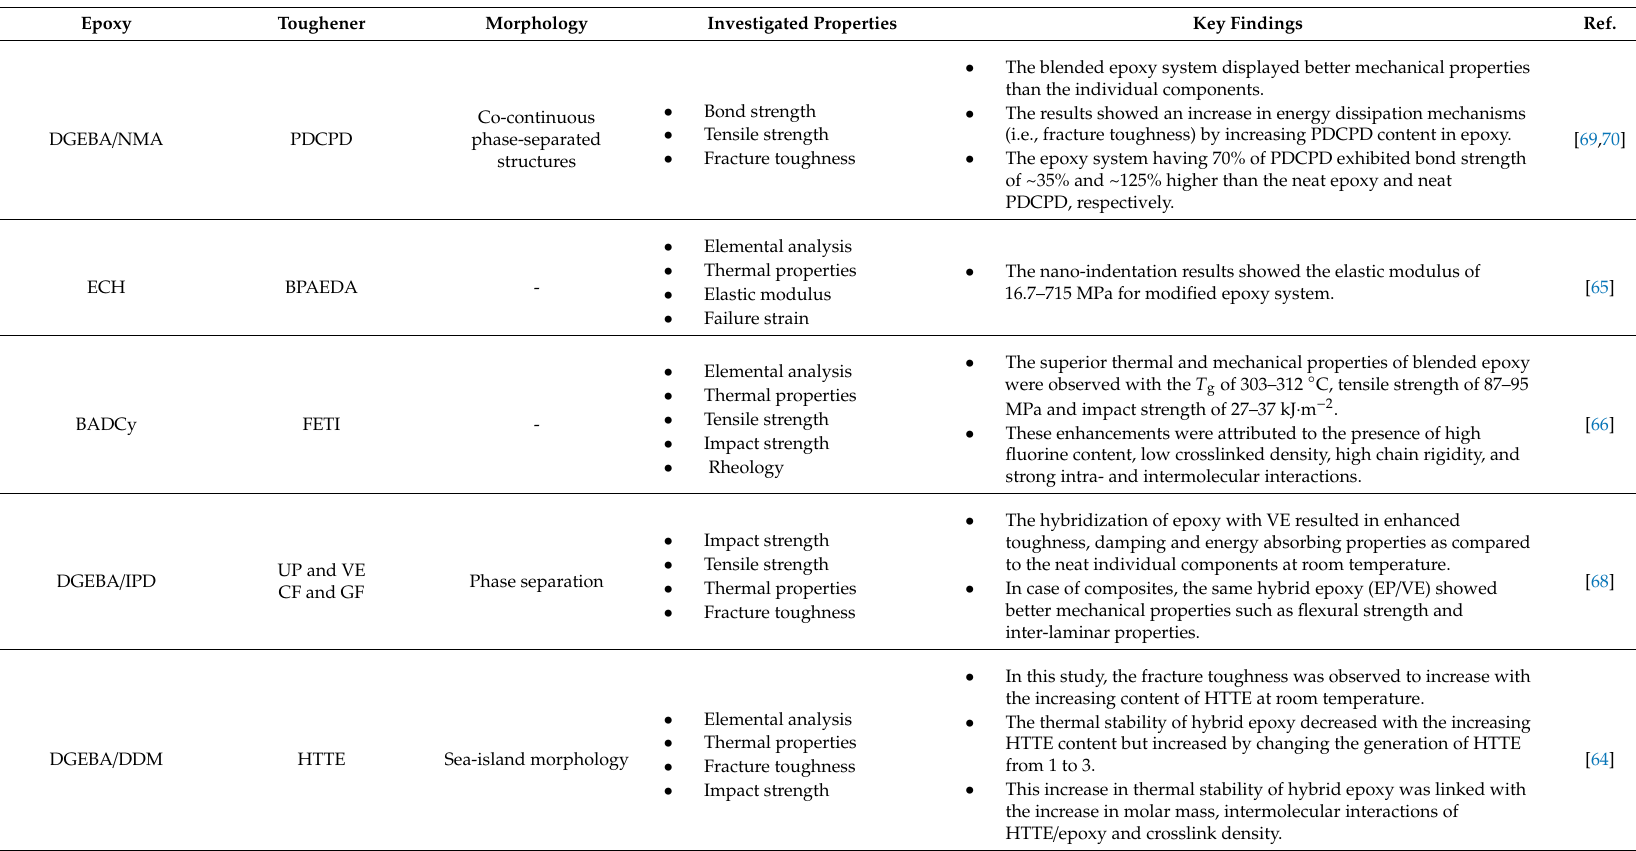
Table 3. Brief summary of di ff erent IPN based systems investigated in literature for epoxy modification using